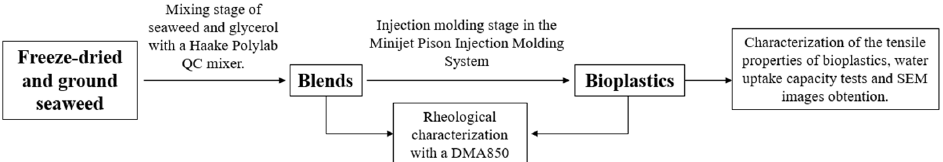
Figure 1. Schema of the production process and characterization of bioplastics. Figure 1. Scheme of the production process and characterization of